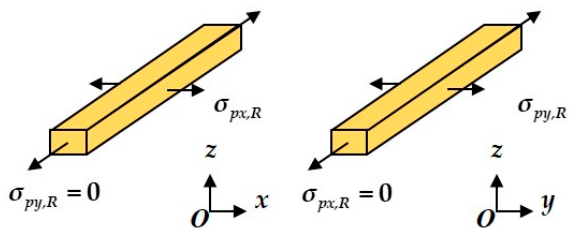
Figure 4. The stress of the infinitesimal element at the border position on the upper surface of the MFC. The strain at the border position on the upper surface of the MFC